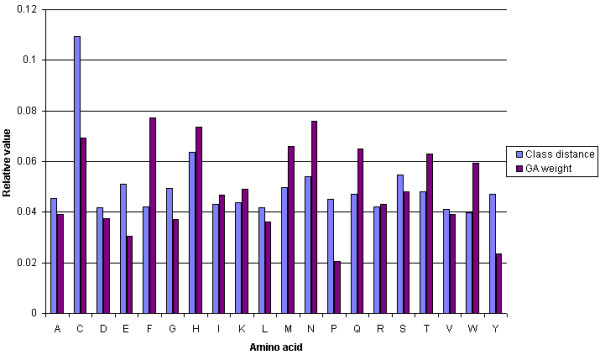
Comparison between GA weightings and difference ratios. Relationship between GA derived weights for amino acids and weights based simply on average compositional distances between classes.